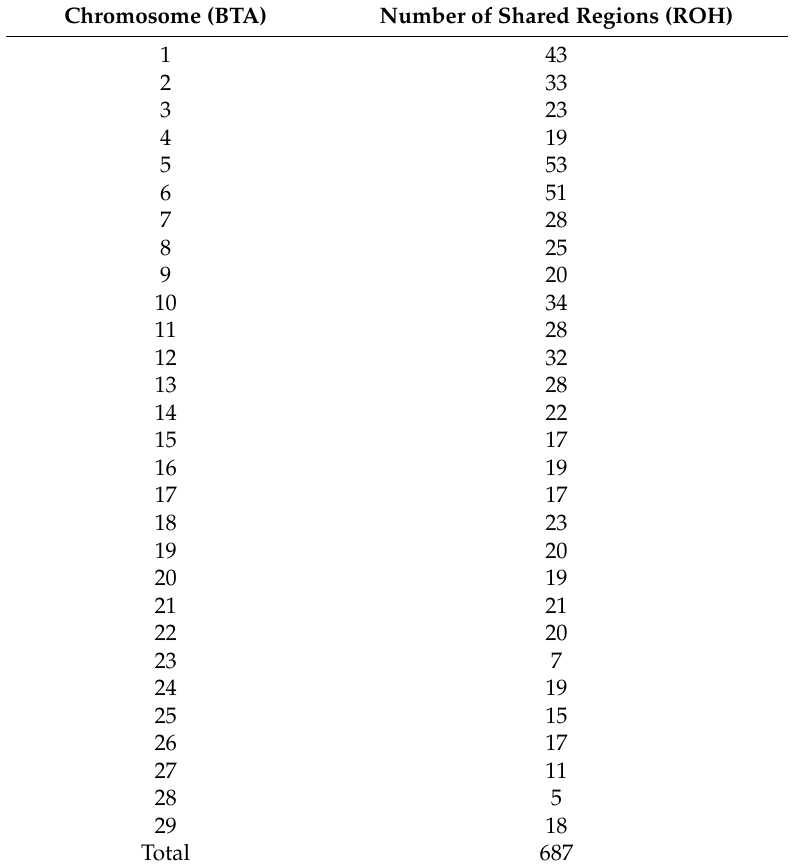
Table 2. Homozygous regions per chromosome.